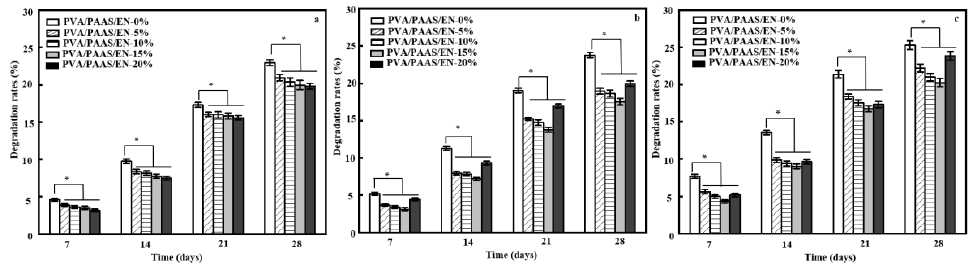
Figure 4. Degradation rates of nanofibers under different ultrasound times: ( a ) 0 min, ( b ) 15 min, and ( c ) 30 min. (* p < 0.05, n = 5).